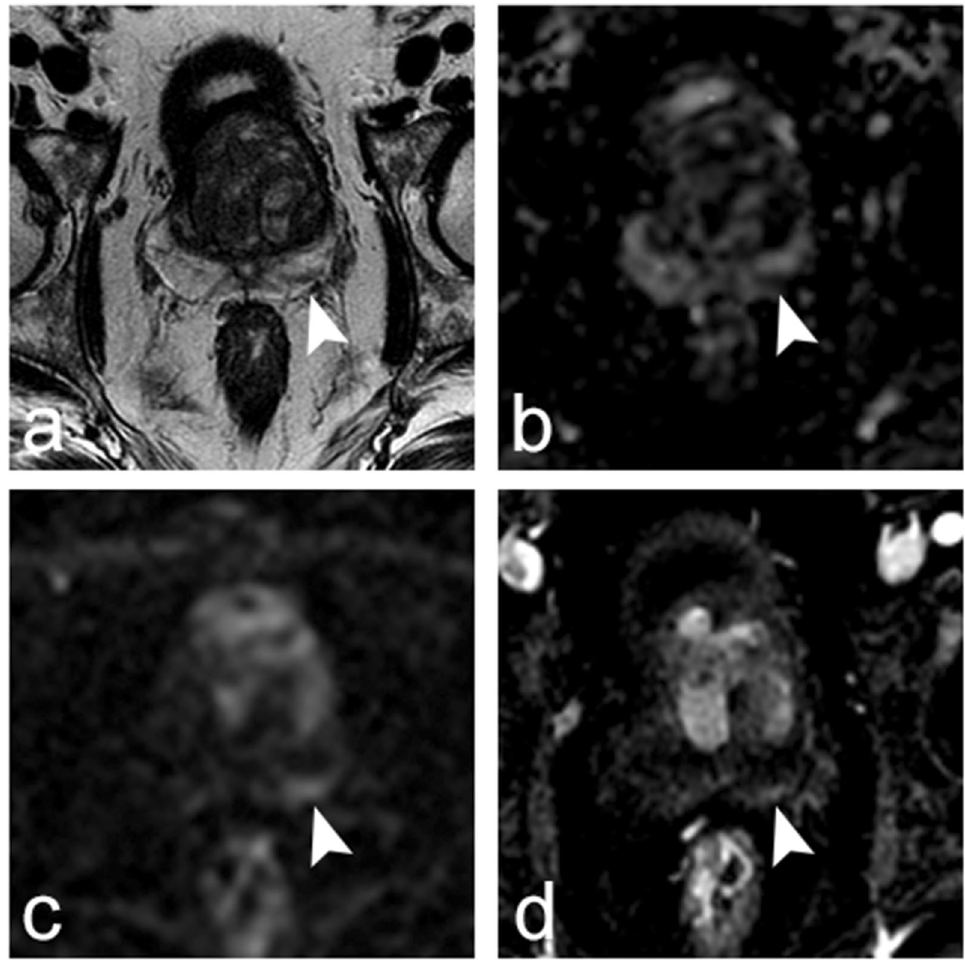
Fig. 2 Axial images obtained in a 62-year-old patient with prostate-specific antigen (PSA) level of 8.1 ng/mL and normal digital rectal examination. Prostate multiparametric magnetic resonance imaging ( a , T2-weighted image; b , apparent diffusion coefficient map; c , diffusion-weighted trace image obtained with b value of 2000 s/mm 2 ; and d , dynamic contrast-enhanced image) showed a 13-mm linear lesion parallel to the capsule in the peripheral zone of the left base ( a – d , arrowheads). Using PI-RADSv2 descriptors, 17 readers assigned to the lesion a T2-weighted imaging (T2WI) category of 2 (‘Linear, wedge-shaped or diffuse mild hypointensity, usually indistinct margin’), two readers a T2WI category of 3 (‘Heterogeneous signal intensity or non-circumscribed, rounded, moderate hypointensity’) and two readers a T2WI category of 4 (‘Circumscribed, homogeneous moderate hypointense focus/mass confined to prostate and < 1.5 cm in greatest dimension’). Two readers assigned a diffusion-weighted imaging (DWI) category of 2 (‘Indistinct hypointense on ADC ‘), fifteen readers a DWI category of 3 (‘Focal mildly/moderately hypointense on ADC